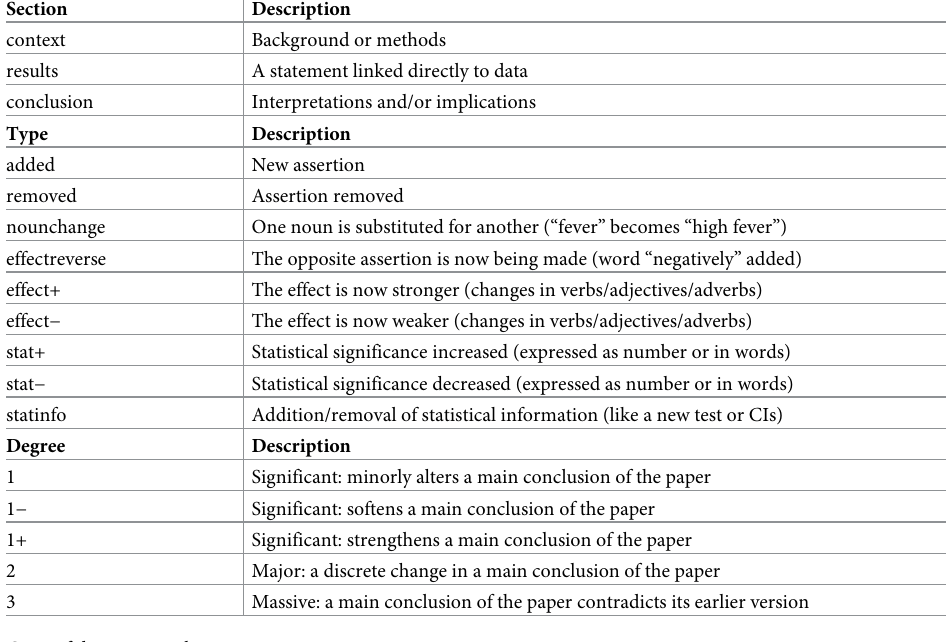
Table 1. Tags (1 each of section, type, and degree) applied to each annotation of text meaningfully changed in